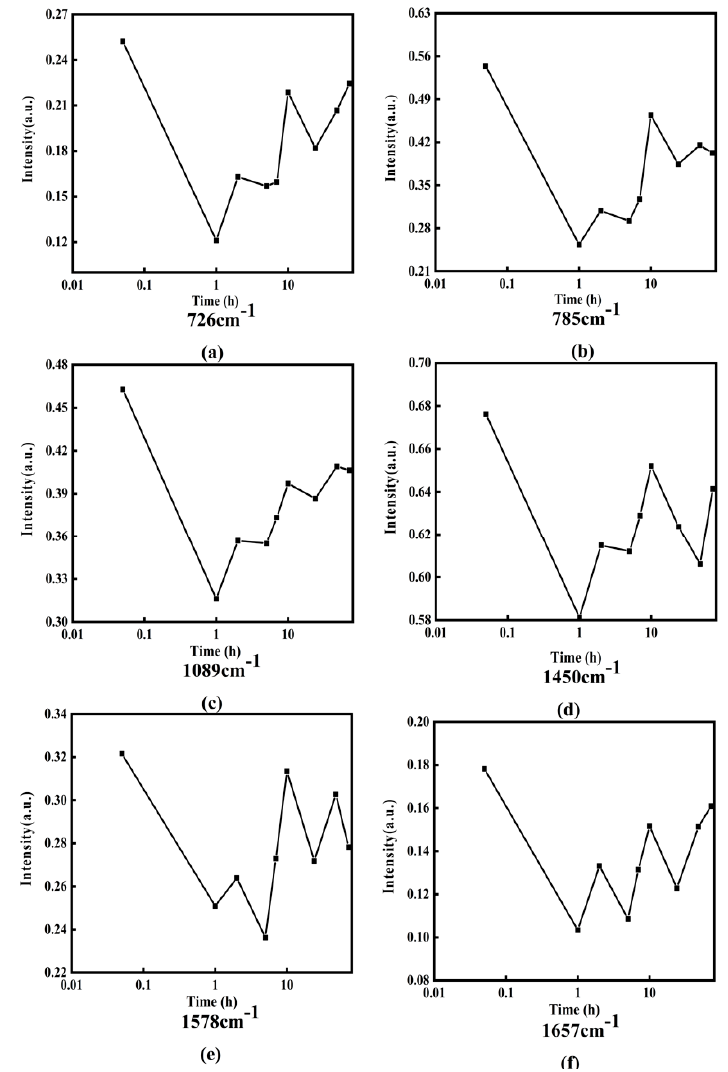
Figure 9. Line charts of Raman intensity change with incubation time at various wave numbers (cm (cid:2879)(cid:2869) ): ( a ) 726, ( b ) 785, ( c ) 1089, ( d )1450, ( e ) 1578, and ( f ) 1657. ( cm − 1 ): ( a ) 726, ( b ) 785, ( c ) 1089, ( d )1450, ( e ) 1578, and ( f )